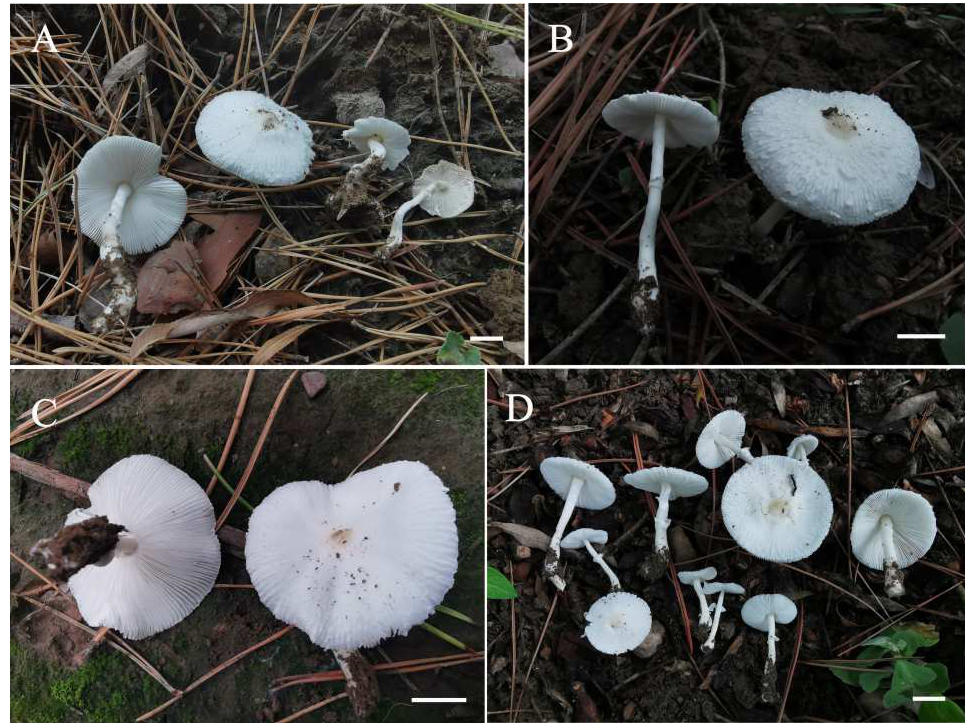
Figure 2. Basidiomata of Leucoagaricus albosquamosus . ( A , B ): CFSZ 20662; ( C ): CFSZ 22880; ( D ): CFSZ 22890). Scale bars: 1 cm.